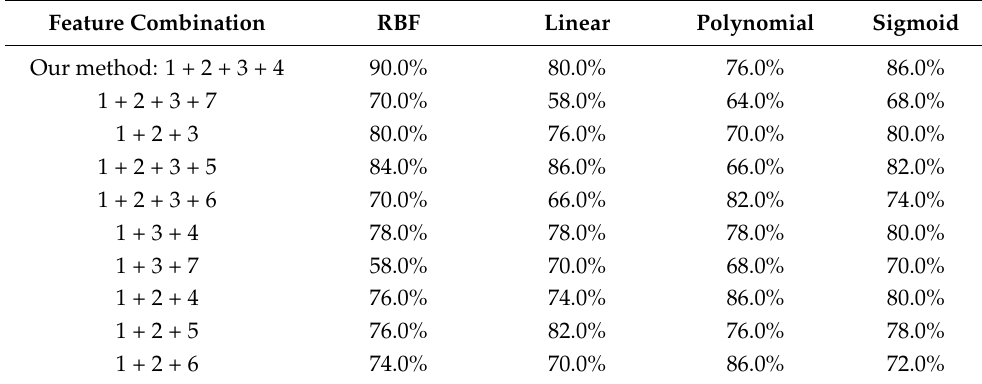
Table 16. The accuracy of GA-SVR with different kernel functions.